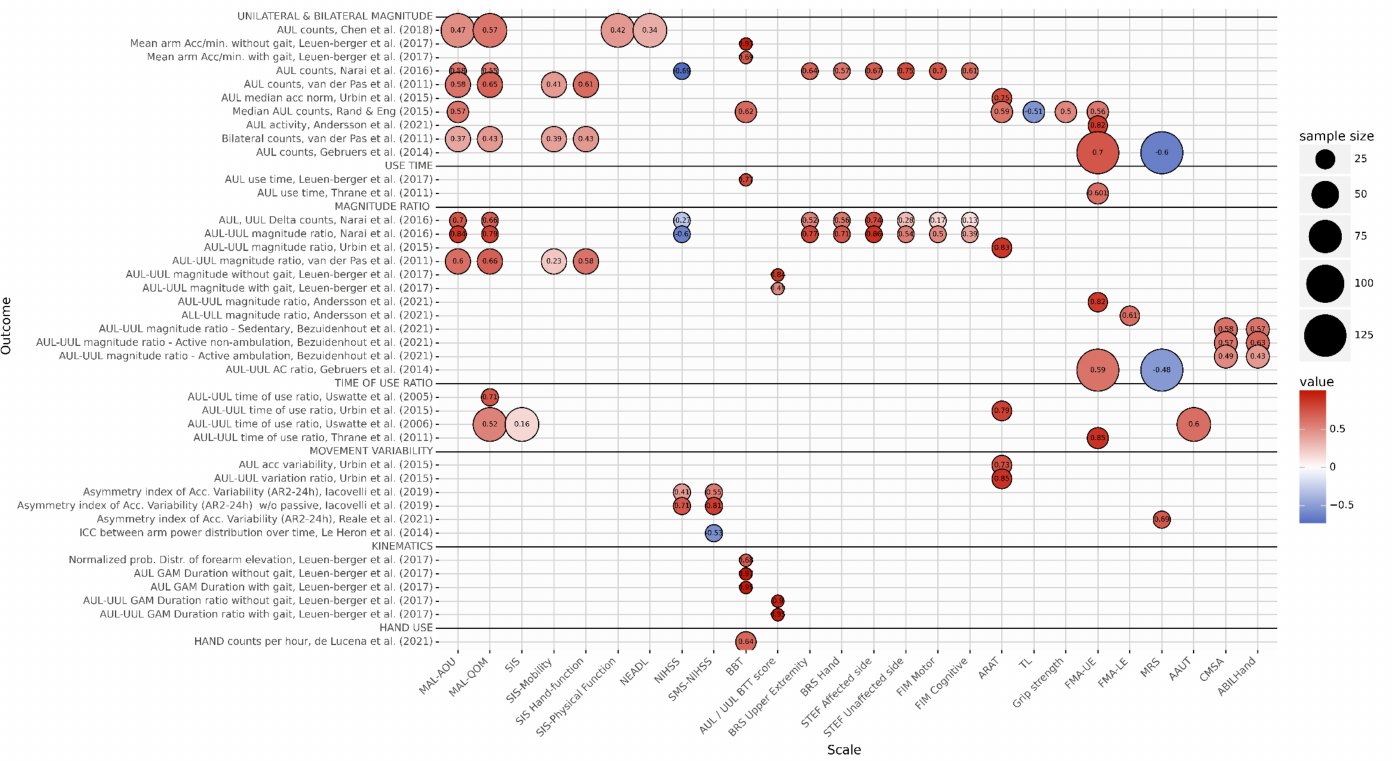
Figure 3. Correlation Between outcomes and Clinical Scales. Outcomes have been grouped by unilateral and bilateral magnitude, use time, magnitude ratio, time of use ratio, movement variability and kinematic outcomes. Color represents correlation value with the clinical scales, with hot colors expressing positive correlation and cold colors negative correlation. Size of the circles represents the size of the sample of the related study. The name of the outcomes remains as close as possible as in the original study. List of abbreviations: AC = activity counts, Acc = Acceleration, AR2-24 h = Asymmetry Rate Index (see ref.), ALL = Affected Lower Limb, AUL = Affected Upper Limb, GAM = Gross Arm Movement, ULL = Unaffected Lower Limb, UUL = Unaffected Upper Limb. Clinical Scales: AAUT = Actual Amount of Use Test, ARAT = Action Research Arm Test, BBT = Box and Blocks Test, BRS(-UE, -H) = Brunnstrom Recovery Stage (Upper Extremity, Hand), CMSA = Chedoke McMaster Stroke Assessment Scale, FIM (-M, -C) = Functional Independence Measure (Motor, Cognitive), FMA(-UE)(-LE) = Fugl-Meyer Assessment (Upper Extremity)(Lower Extremity), MAL(-AOU, -QOM) = Motor Activity Log (Amount of Activity, Quality of Movement), MRS = Modified Rankin Scale, NEADL = Nottingham Extended Activities of Daily Living, (SMS-)NIHSS = (Supplementary Motor Scale) National Institute of Health Stroke scale, SIS = Stroke Impact Scale, STEF = Simple Test for Evaluating Hand Function, TL = Thumb Localization Test